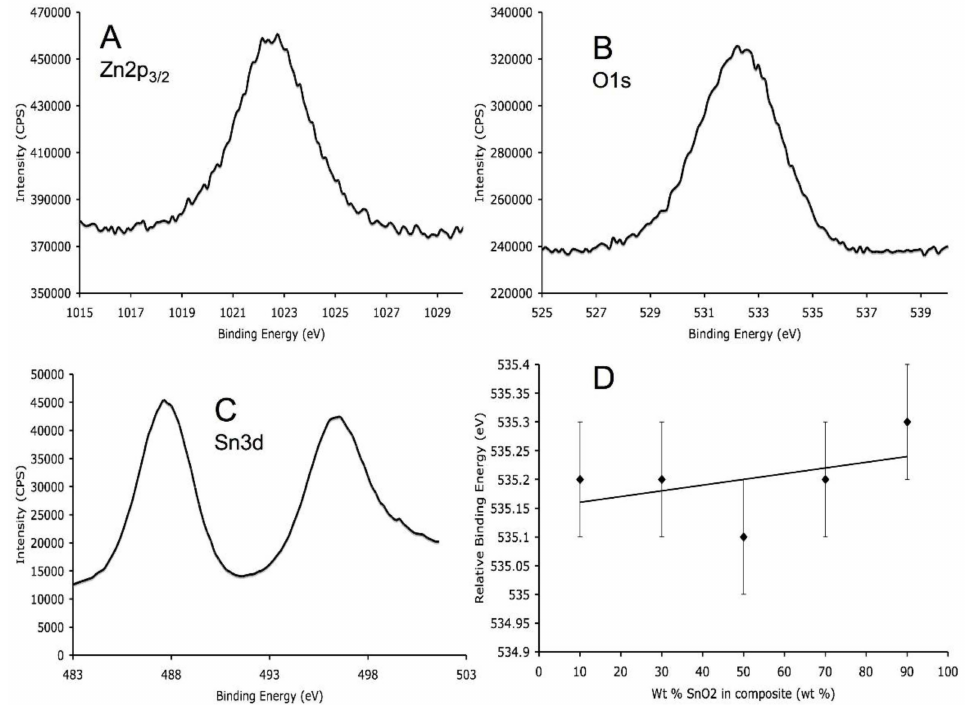
Figure 4. High resolution XPS scans of the 50 wt% ZnO:50 wt% SnO 2 sample for ( A ) the Zn2p 3/ 2 peak, ( B ) the O1s peak, ( C ) the Sn3d peaks and ( D ) the XPS data of the relative binding energies